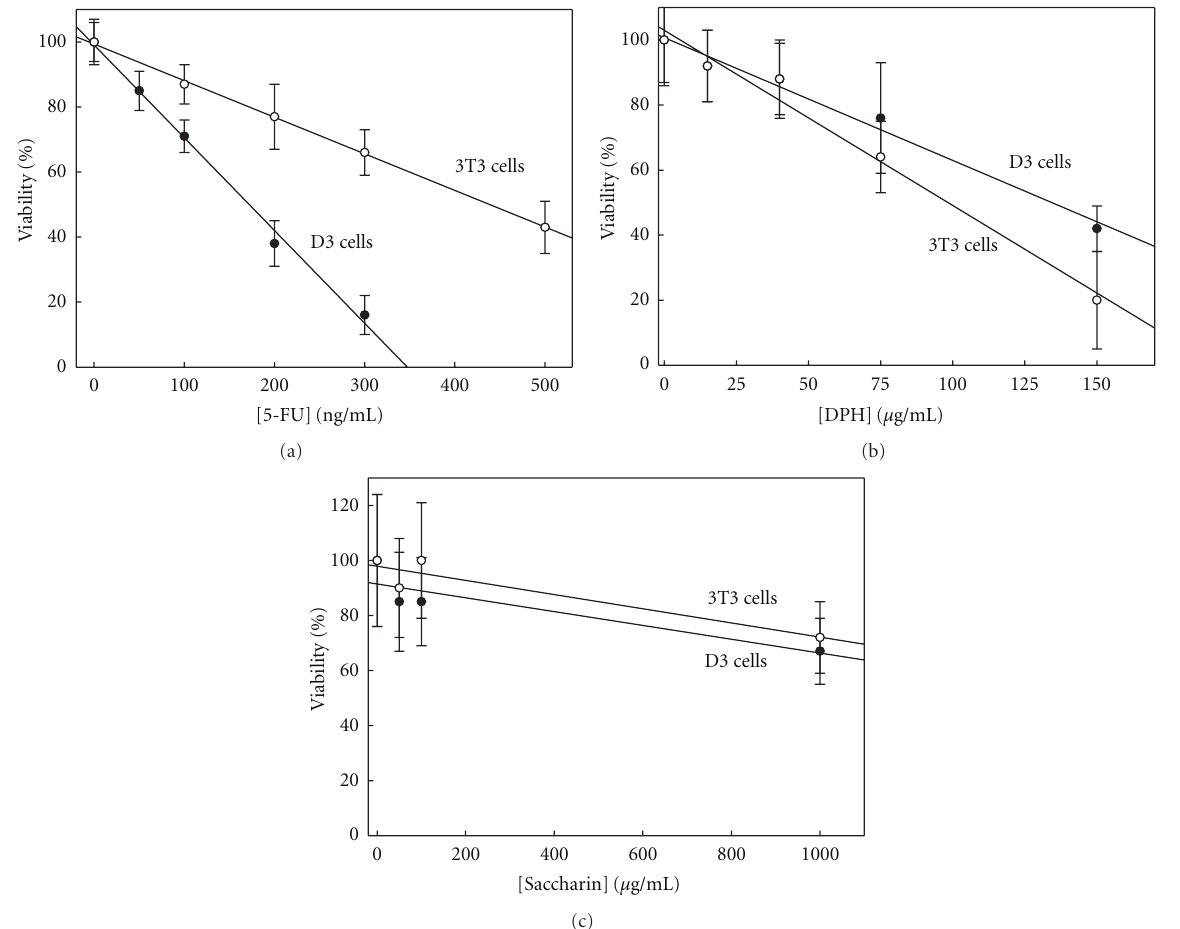
Figure 1: E ff ect of 5-FU, DPH, and saccharin on cell viability. D3 and 3T3 cells were cultured on monolayers exposed to 5-FU (a), DPH (b), or saccharin (c) for 5 days. Then the MTT test was performed as described in Section 2. D3 cells were cultured under spontaneous di ff erentiation (in the absence of LIF). The results are expressed as a percentage of absorbance at 570 nm with regards to the control cultures, which were not exposed to 5-FU, DPH, or saccharin. Each condition was assayed with twelve independent